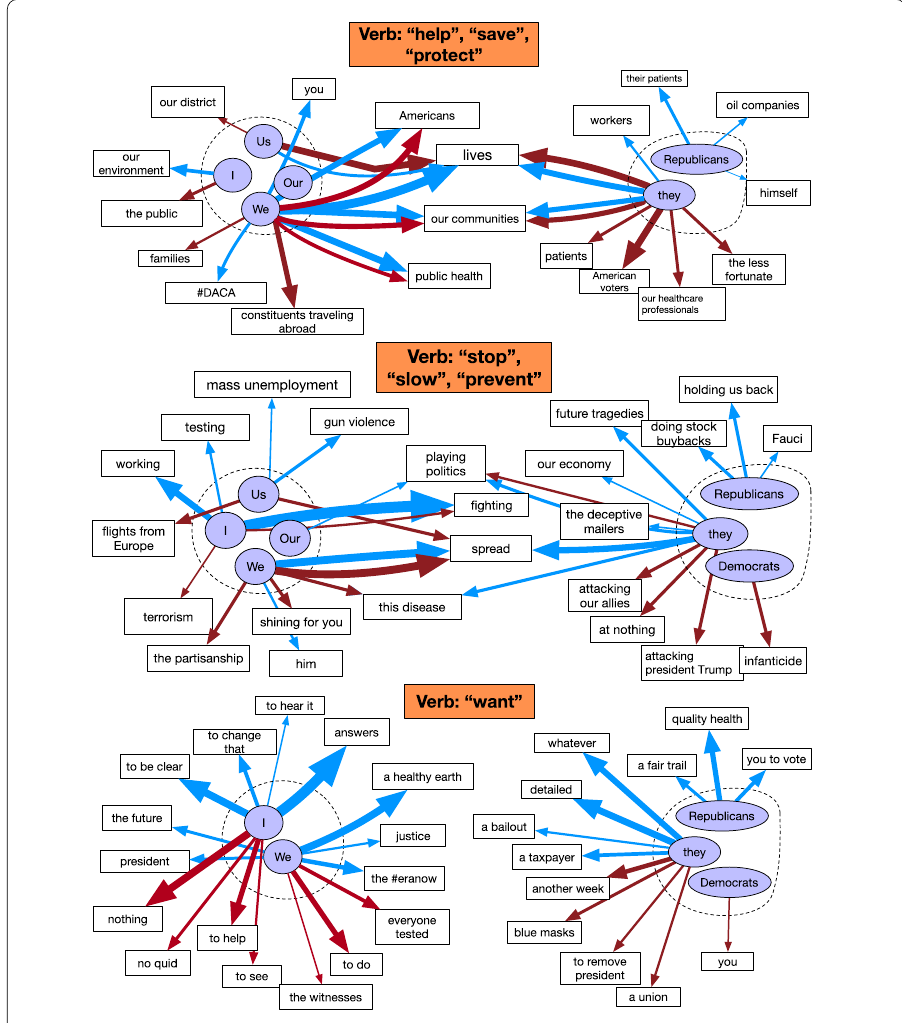
Figure 5 Agents and Patients for selected sets of verbs with the highest frequencies. Some Patients with similar meanings are combined or omitted. Blue arrows represent relationships found in Democratic tweets, and red in Republican tweets. The sizes of arrows indicate the frequencies of the